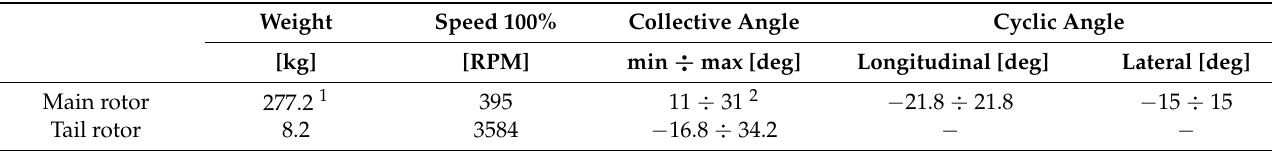
Table 1. Tail rotor collective angle range, tail and main rotors weight, speed ([1], pages 303, 254 and 157), tail rotor speed ([17], page 3) and cycling angle range ([18], page